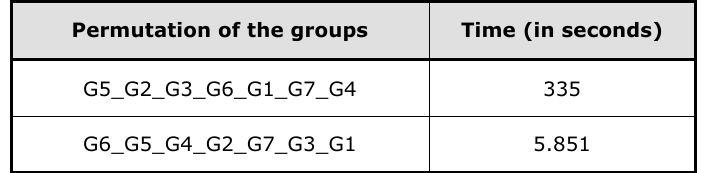
Table 2. “Best and worst permutations of the groups of